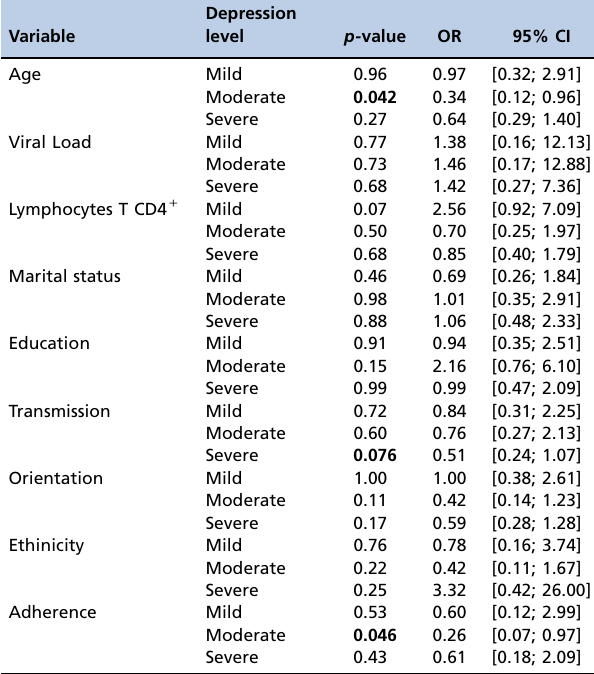
Table 3 - Demonstration of the Log-linear class for categorized data analysis regarding depression as a response variable related to the other